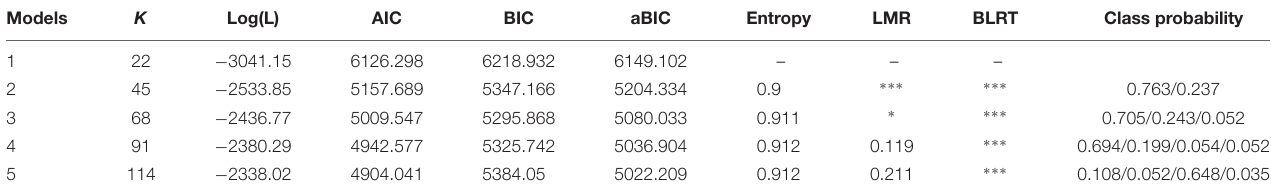
TABLE 2 | The LCA fit index of transformational